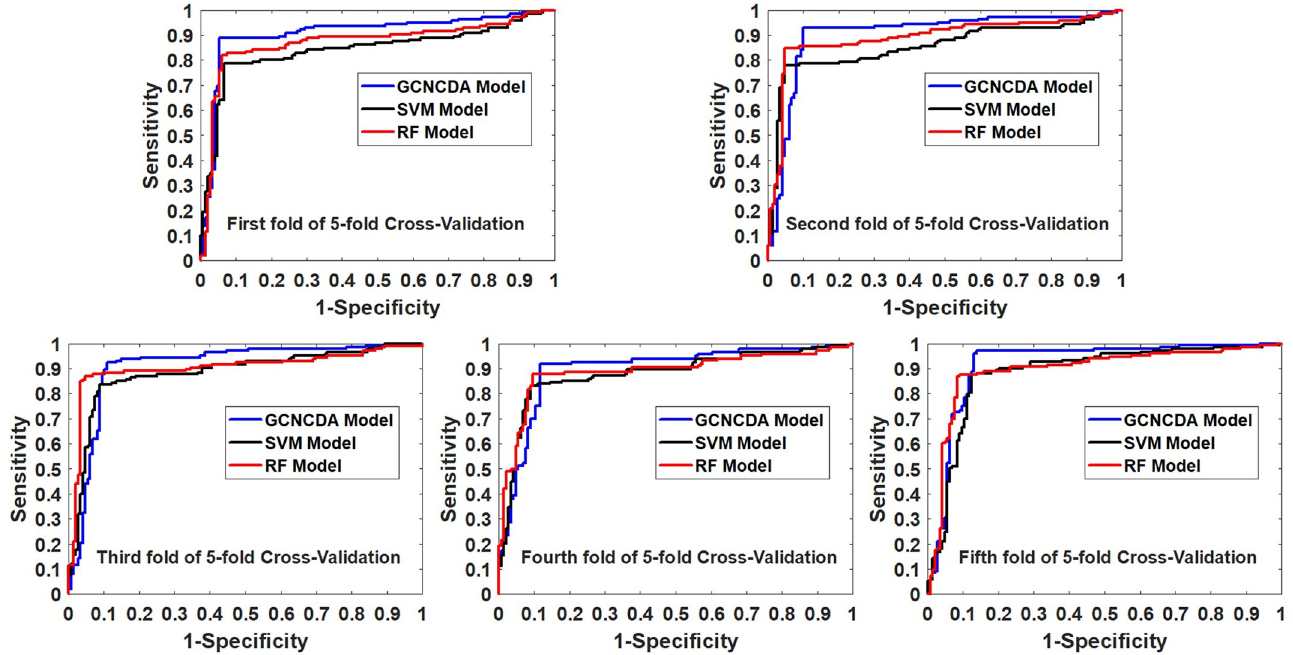
Fig 2. Comparison of ROC curves obtained by different classifier models in 5-fold CV on circR2Disease dataset.